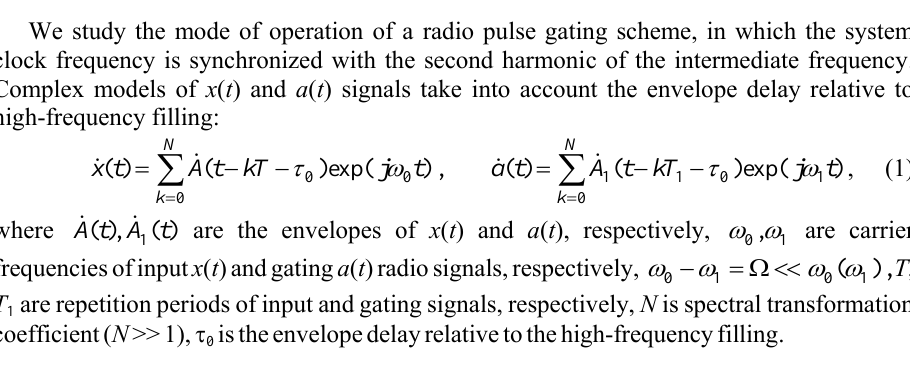
Fig. 2. Mathematical model of the radio pulse stroboscopic